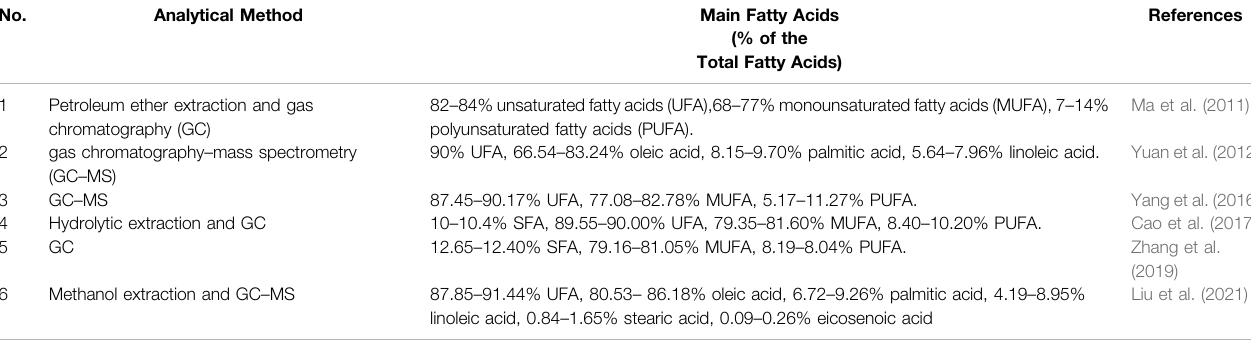
TABLE 1 | Fatty acid composition of camellia oil according to studies using different extraction methods.